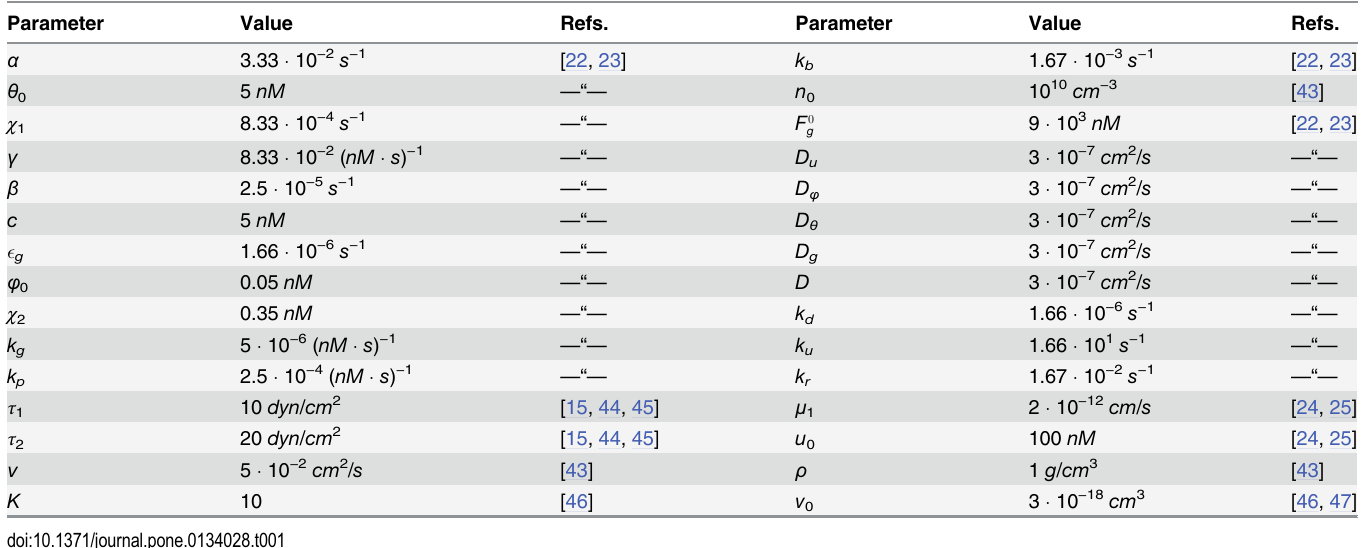
Table 1. Parameter values. Parameter